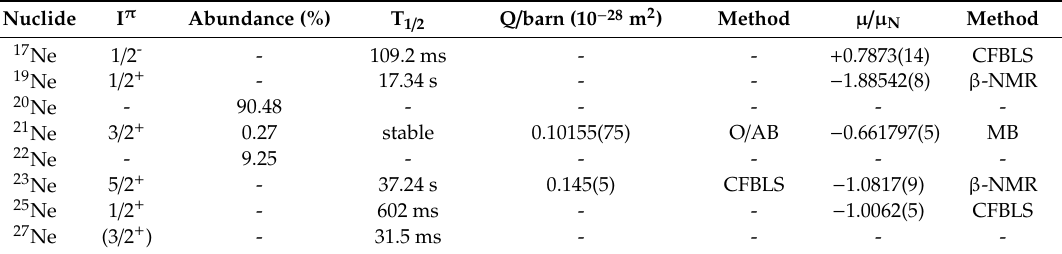
Table 3. Electromagnetic properties of neon isotopes [53]